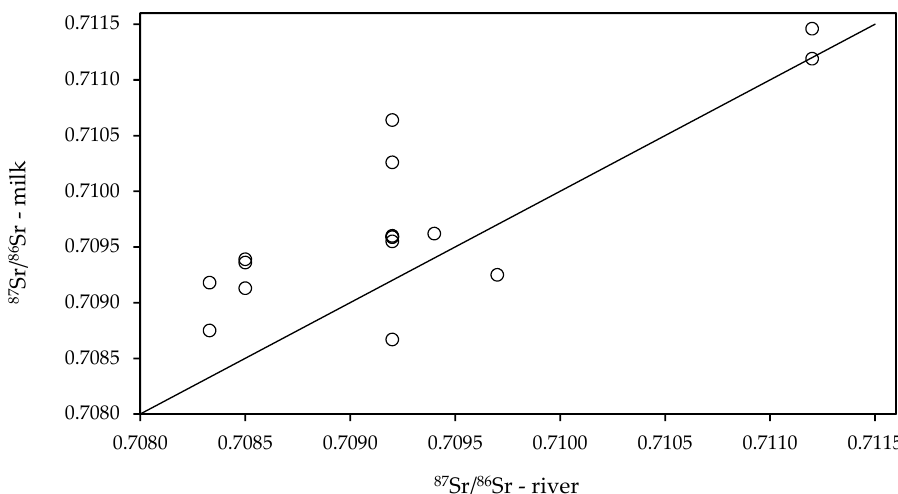
Figure 5. Relationship between 87 Sr/ 86 Sr ratios in rivers and milk. The line represents the 1:1 ratio indicating overlapping of the data.